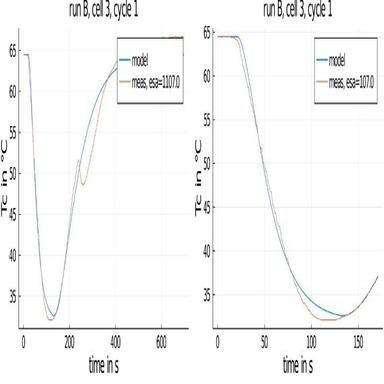
Temperature profiles in run B, first drying cycle: entire drying time (left), drying time until ΔT = 5 ◦ C (right).